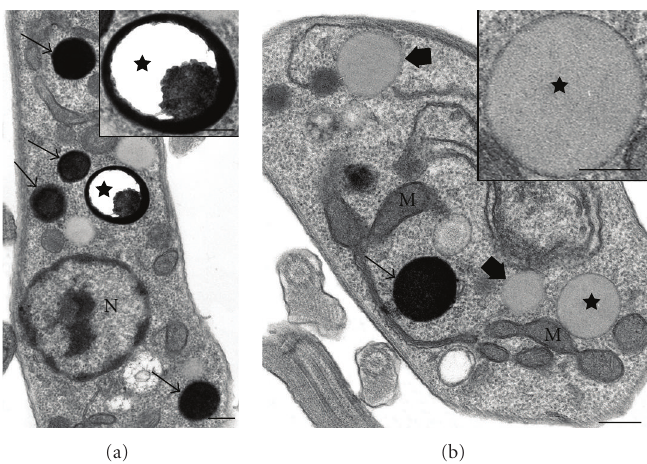
Figure 10: Treatment of promastigotes with ER-119884 induces the accumulation of several lipid droplets in the cytosol, sometimes appearing as an electrondense structure due to osmium tetroxide concentration ((a)-(b), small arrows ), and as a classic lipid body surrounded by a phospholipid monolayer ((b), large arrows ). At high magnification ( stars ), it is evident that the structures are completely di ff erent, probably indicating a distintic nature of the lipids that accumulate in these inclusions. M, mitochondrion; N, nucleus. All images are reproduced with permission from [37] American Society for Microbiology. Bars, 0 . 5 μ m.